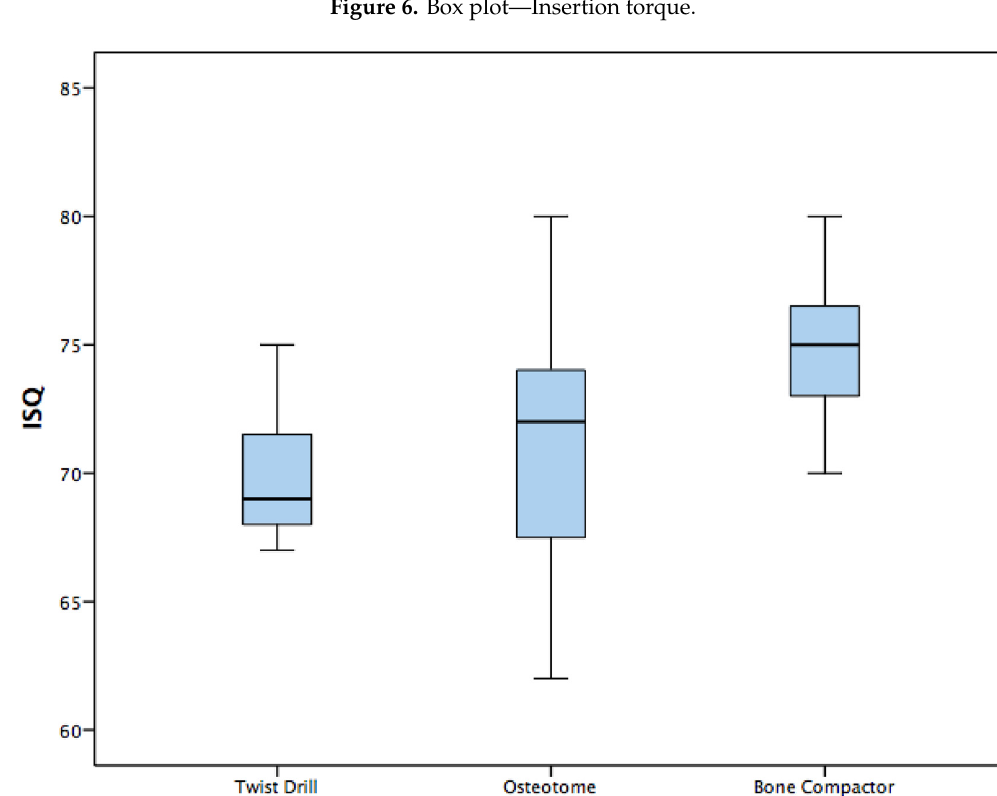
Figure 7. Box plot—Implant stability quotient (ISQ).